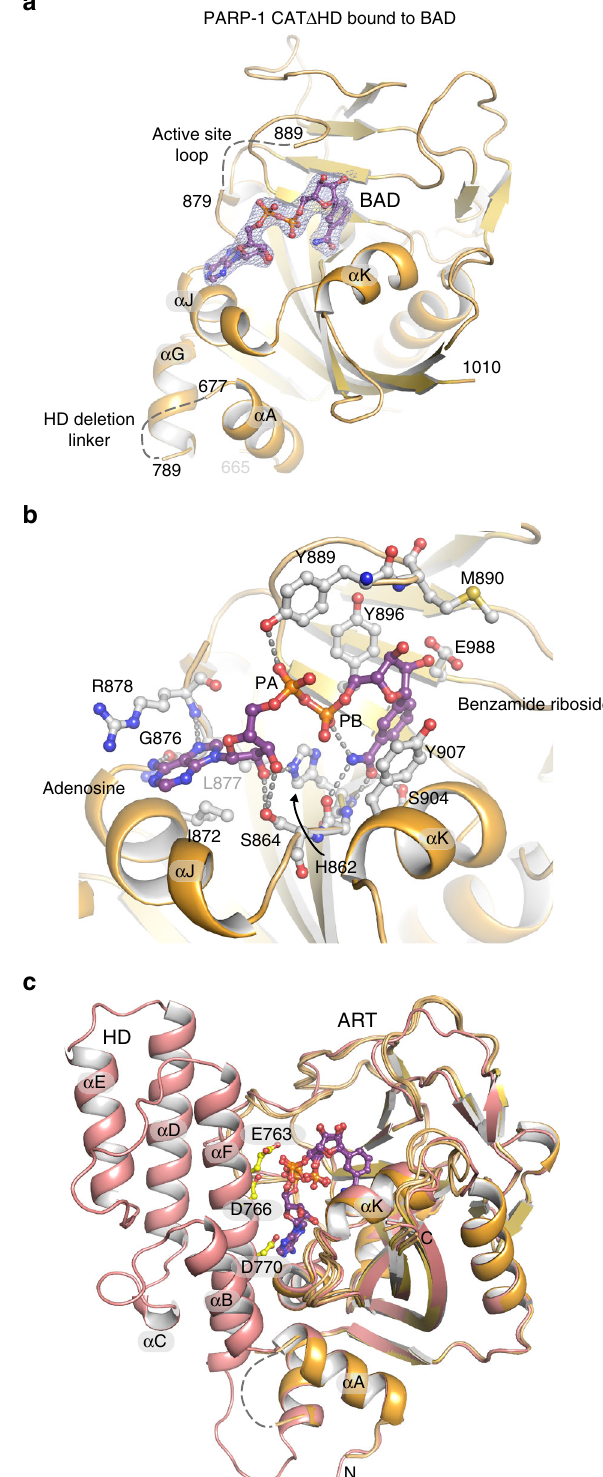
Fig. 2 Crystal structure of PARP-1 CAT Δ HD bound to NAD + analog BAD. a Crystal structure of the PARP-1 CAT domain carrying a HD deletion (residues 661 – 1011 with an 8-residue linker GSGSGSGG replacing residues 678 – 787) bound to BAD at 2.3 Å resolution. Four PARP-1 CAT Δ HD molecules were present in the crystal asymmetric unit; molecule C is shown. A 2.3 Å 2F O − F C weighted electron density contoured at 1.2 σ in the region of the bound BAD molecule is overlaid on the structure (see also Supplementary Fig. 1a, b). b Close-up view of the NAD + binding site and contacts formed with the NAD + analog BAD in molecule C. c The crystal structure of human PARP-1 CAT domain WT (pdb: 3gjw) 40 aligned with the PARP-1 CAT Δ HD/BAD